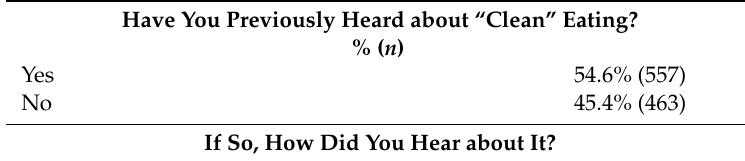
Table 2. Awareness of “clean” eating and sources of